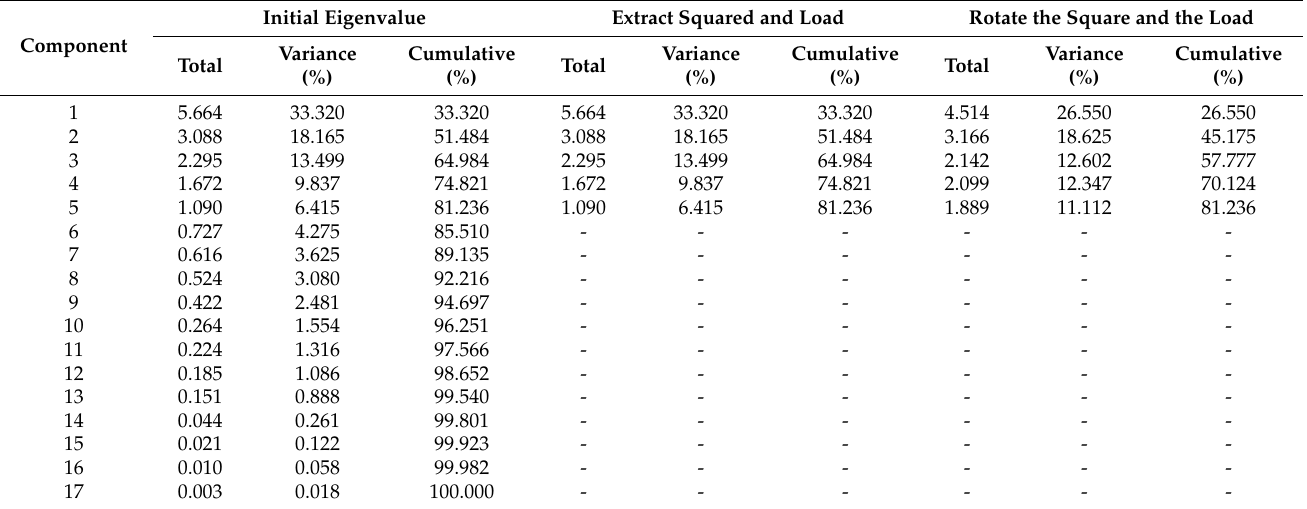
Table 3. Total variance explained.